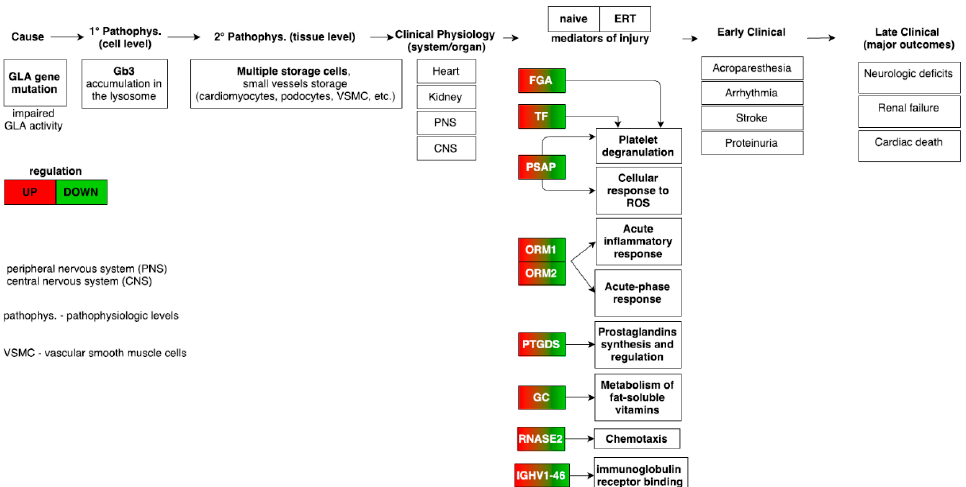
Figure 8. Mapping of the pathophysiologic and molecular features in Fabry-naïve and ERT groups